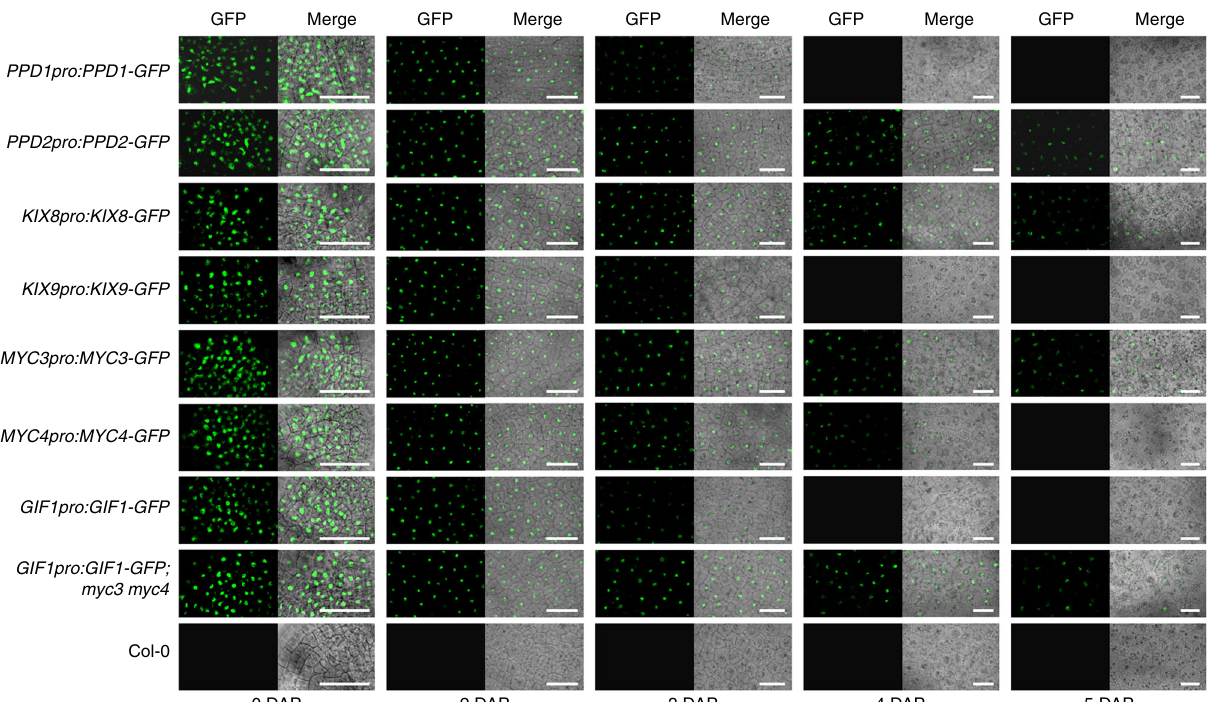
Fig. 6 Expression patterns of KIX8 , KIX9 , PPD1 , PPD2 , MYC3 , MYC4 , and GIF1 in epidermal cells of the outer integuments during seed development. The promotors of KIX8 (2,087bp), KIX9 (1,714 bp), PPD1 (1,797 bp), PPD2 (2,153 bp), MYC3 (2,180 bp), MYC4 (2,132 bp), and GIF1 (2,337 bp) and their CDSs were cloned into the pMDC107 - GFP vector to generate KIX8pro : KIX8 - GFP , KIX9pro : KIX9 - GFP , PPD1pro : PPD1 - GFP, PPD2pro : PPD2 - GFP , MYC3pro : MYC3 - GFP , MYC4pro : MYC4 - GFP , and GIF1pro : GIF1 - GFP constructs, respectively. GFP fl uorescence from the outer integuments of seeds was observed during seed development. DAP days after pollination. Scale bars = 25 μ